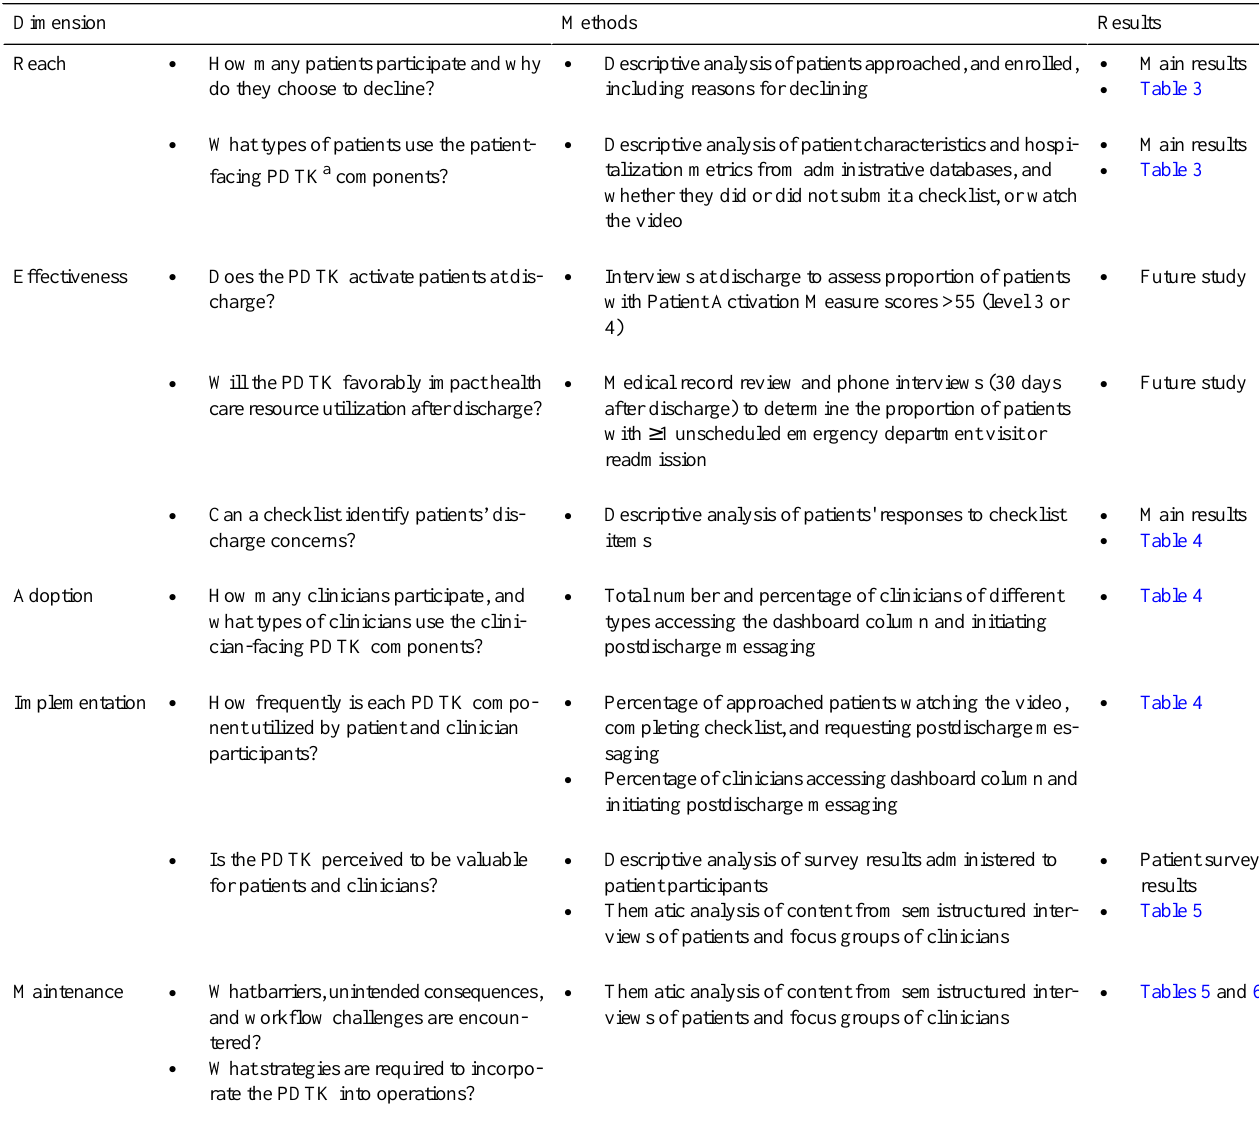
Table 1. Reach, Effectiveness, Adoption, Implementation, and Maintenance framework: research questions and methods of analysis by dimension.